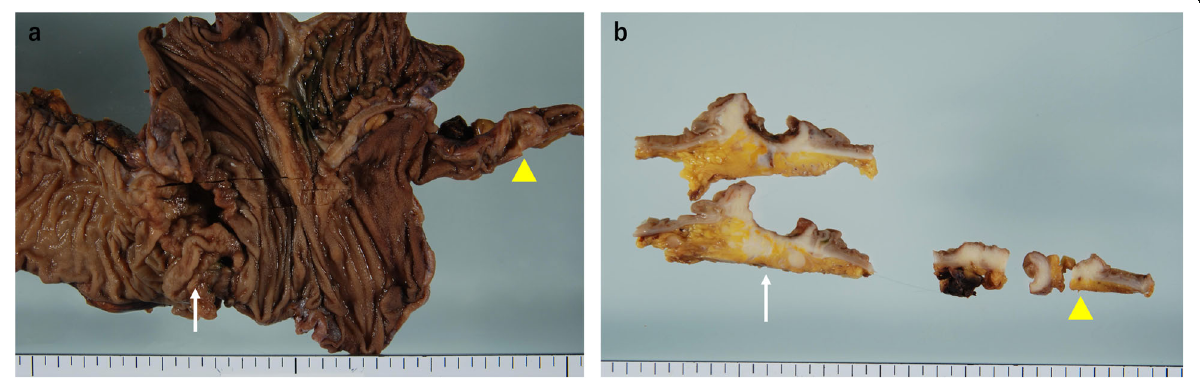
Fig. 2 a Macroscopic examination of the resected specimens showing a circumferential type-2 lesion in the middle of the ascending colon and thickening of the middle of the appendix. b Gross appearance of a cross-section showing the primary tumor (white arrow) in the ascending colon and intramural metastasis in the appendix (yellow